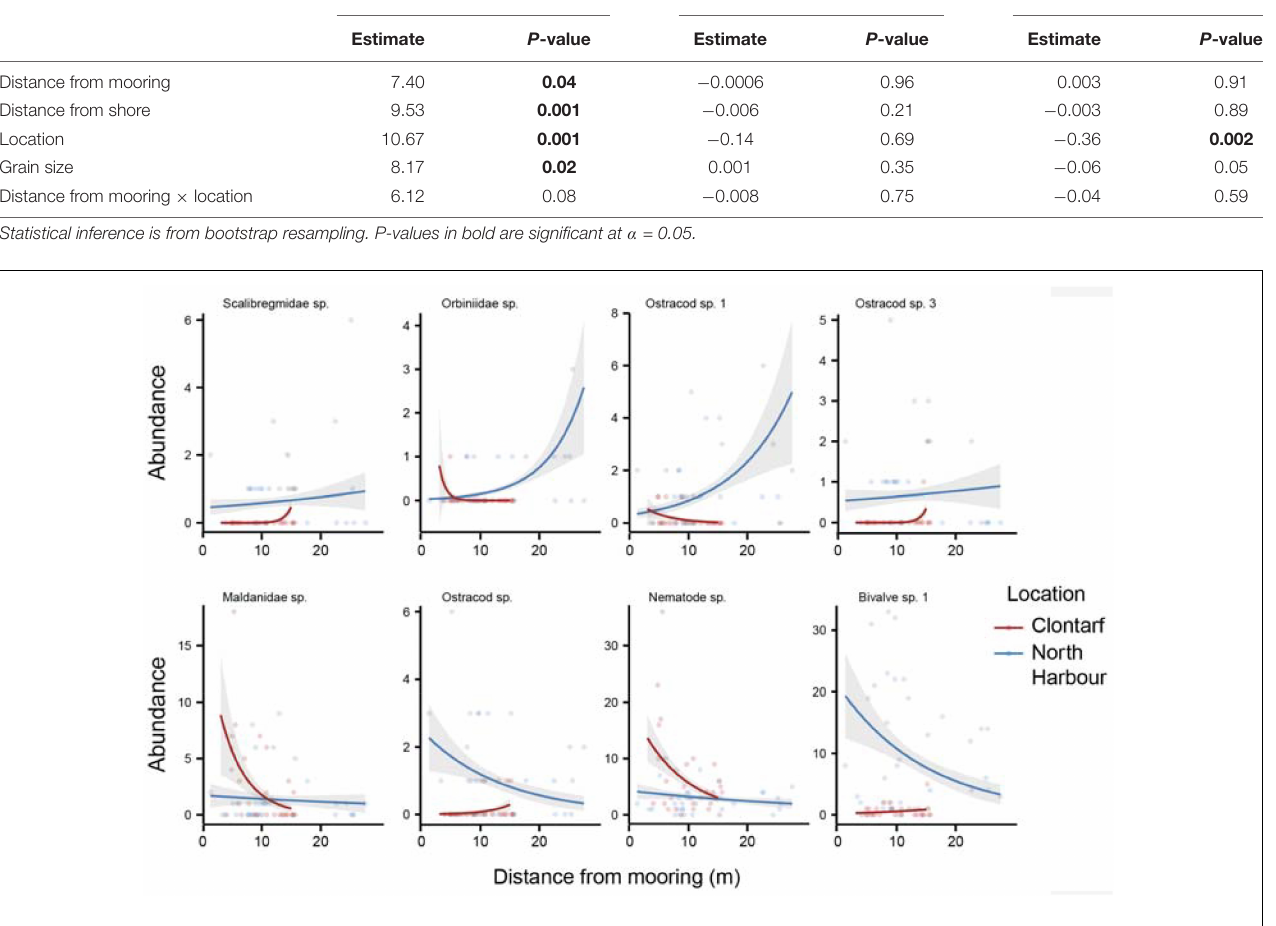
FIGURE 2 | The relationship between infaunal abundance (count per sample) and distance from moorings (m) at the two locations with boating infrastructure (Clontarf, North Harbour). The taxa plotted are the eight morphospecies with the lowest p -values for the distance from moorings predictor variable in the generalized linear models (GLM). Fitted lines are derived from the negative binomial GLMs and shading represents 95%